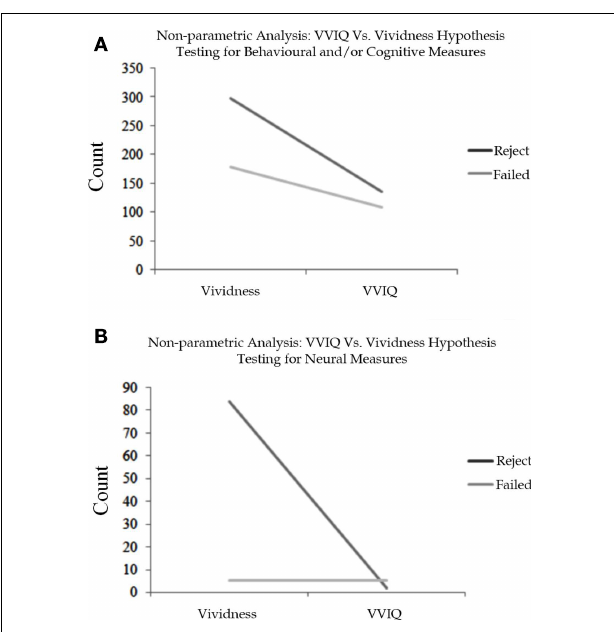
FIGUREA1 | (A) Experimental outcomes for trial-by-trial vividness ratings andVVIQ with respect to behavioral and/or cognitive measures. (B) Experimental outcomes for trial-by-trial vividness ratings andVVIQ with respect to neural measures.The dark line refers to results which reject the null hypothesis, and the light line refers to results which fail to reject the null hypothesis.